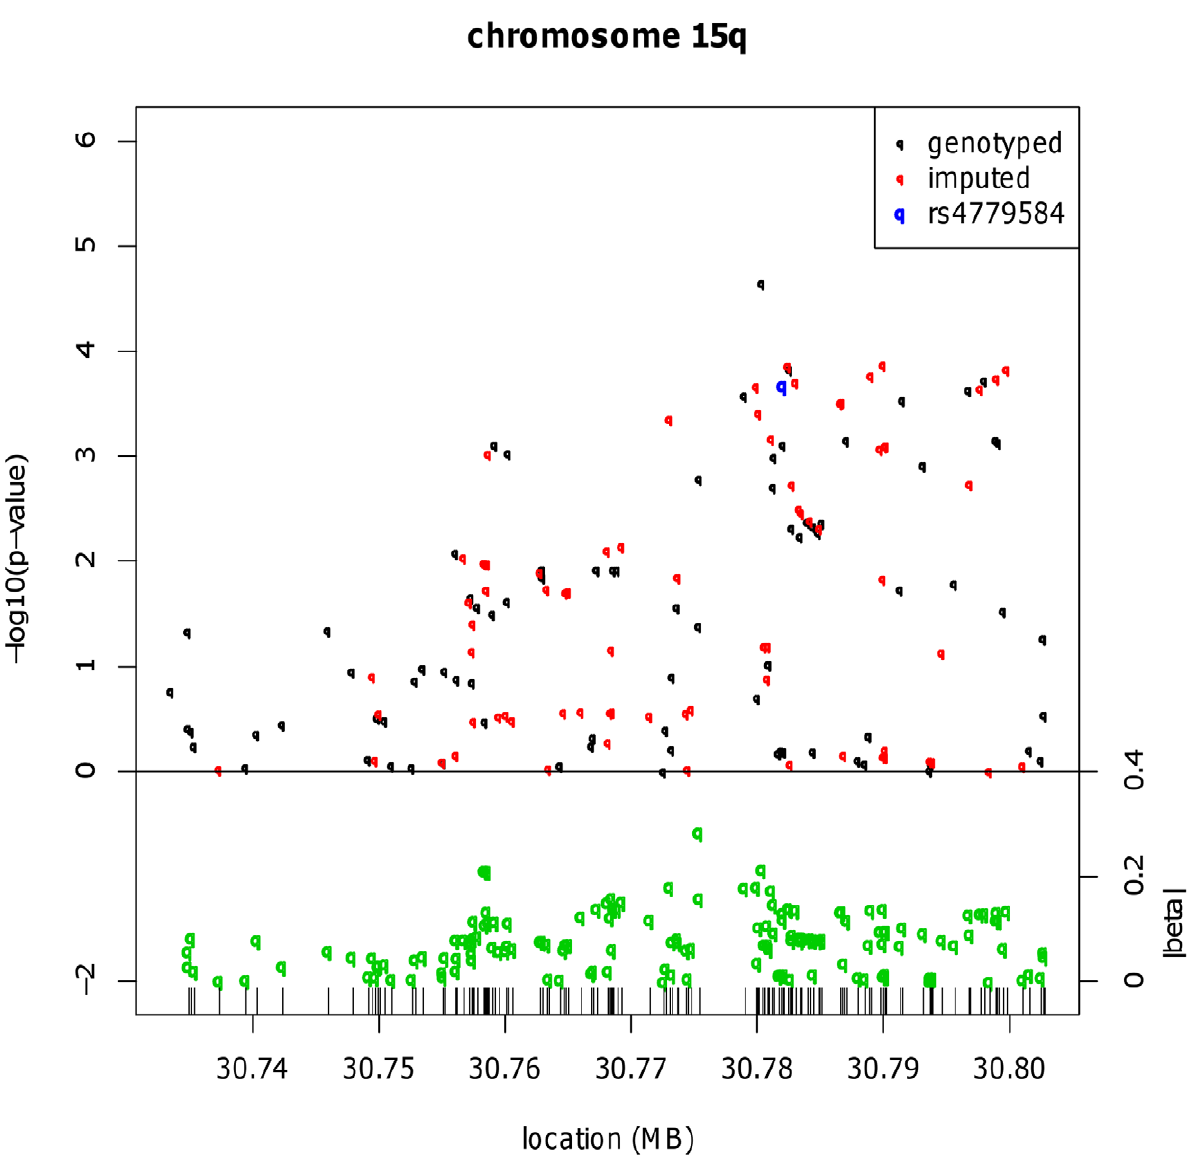
Figure 1. Fine mapping around the known CRC risk SNP close to GREM1 (15q13.3). Results for meta-analysis of UK2 and Scotland2 are shown. Both significance of association ( 2 log 10 (P)) and effect size ( b ) are presented. The original CRC-associated tagSNPs are shown in blue. The SNP with the clearly strongest association signal is the genotyped SNP rs16969681.